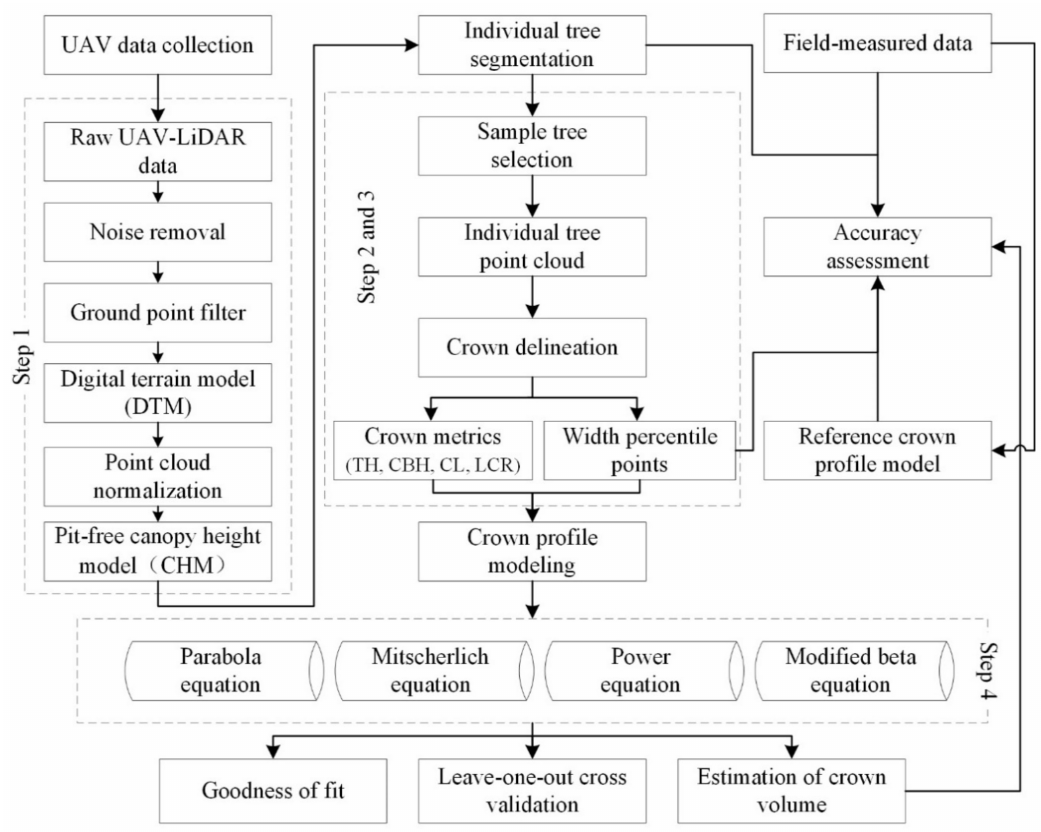
Figure 2. An overview of the workflow for modelling crown profiles using unmanned aerial vehicle (UAV) laser scanning data. TH: tree height; CBH: crown base height; CL: crown length; LCR: largest crown